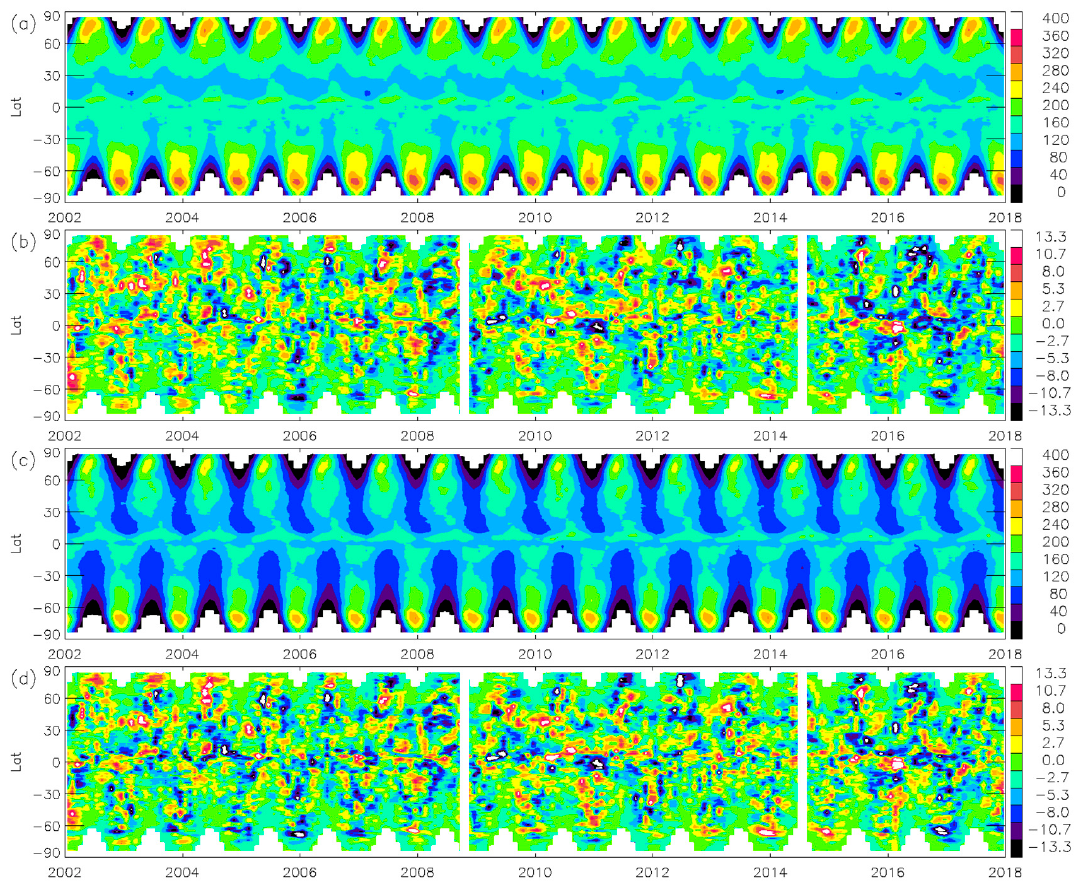
Figure 10. ( a ) MISR blue-band CF radiance, ( b ) deseasonalized CF radiance, ( c ) AN radiance, and ( d ) deseasonalized AN radiance. As in Figure 8, the MISR radiance and radiance difference units are W/m 2 /nm/sr.